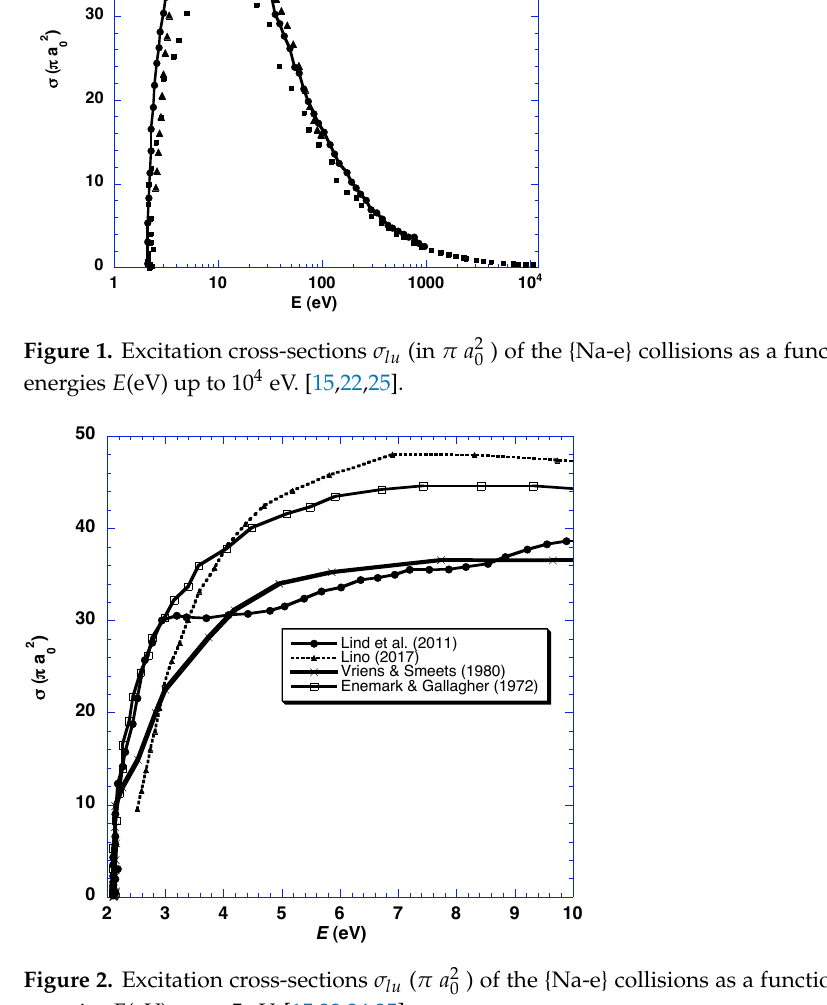
) of the {Na-e} collisions as a function of small kinetic 0